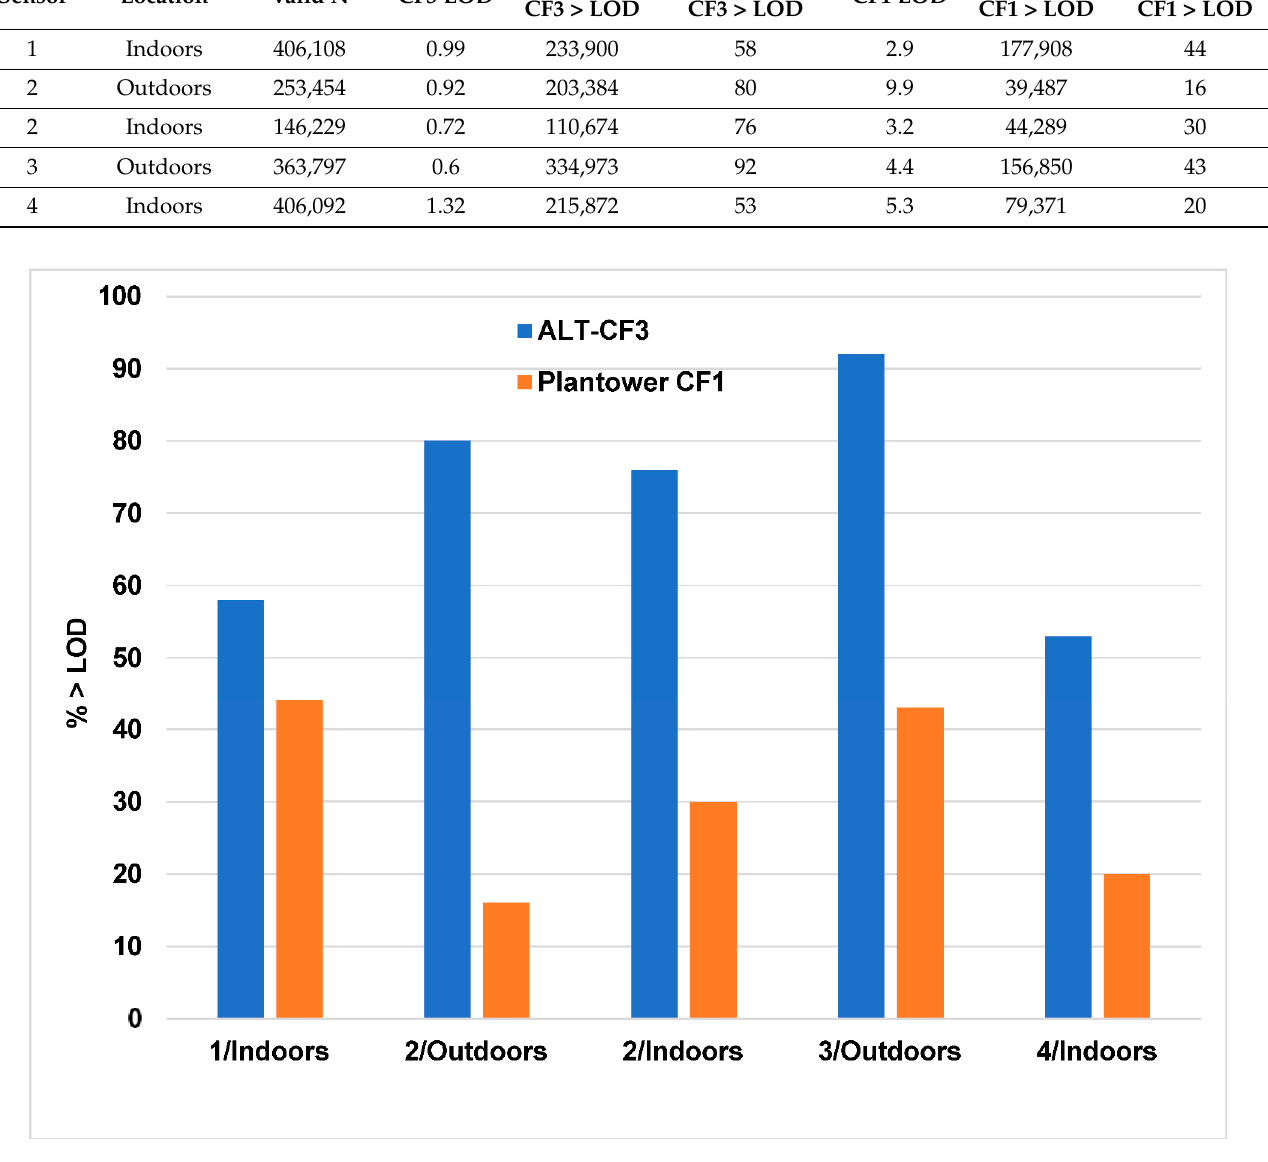
Figure 4. Percent of observations exceeding the LOD compared for the ALT-CF3 and Plantower CF1 algorithms. Monitor/Location shown on x-axis. Table 4. PM 2.5 LODs (µg/m 3 ) calculated for the ALT-CF3 and Plantower CF1 algorithms. Number and percent of observations greater than the LOD.